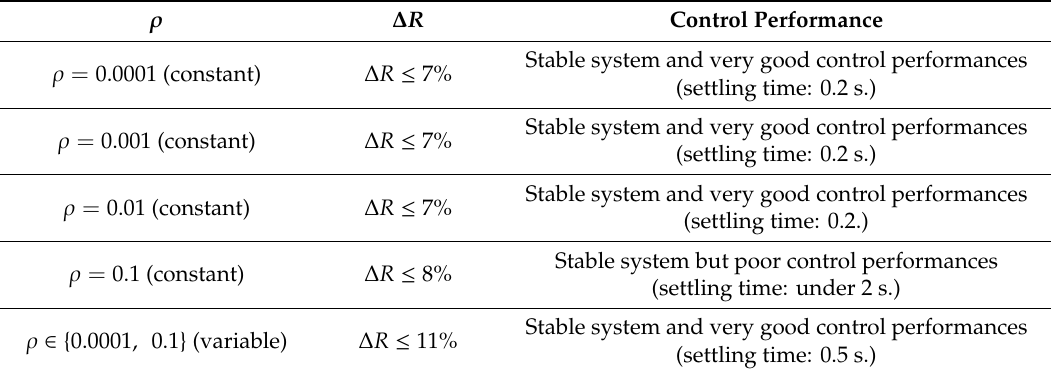
Table 2. The case studies—results for maximum allowed values of electrical load variation ( ∆ R ). ρ ∆ R Control Performance ρ = 0.0001